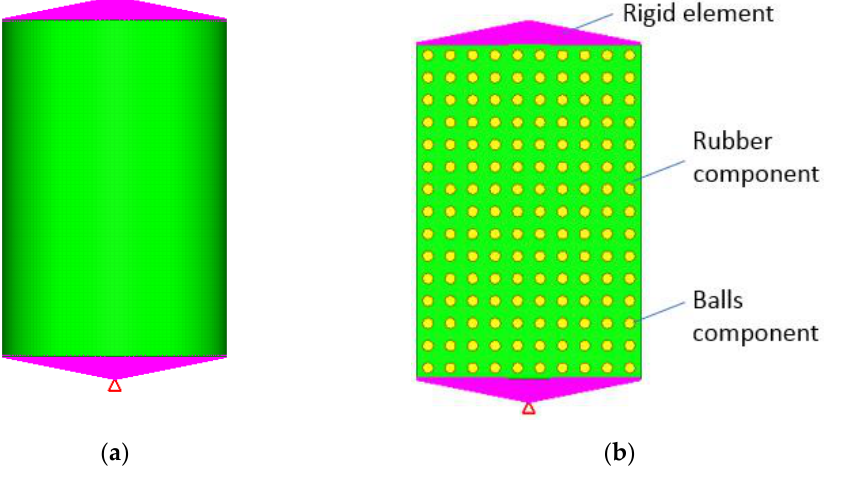
Figure 4. Finite element model of the damper. ( a ) Entire model, ( b ) Section.